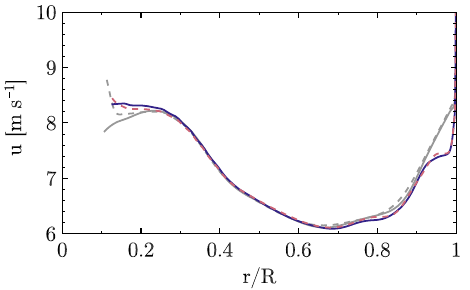
Figure 13. Radial distribution of the axial inflow velocity for CaseIsoRotor (dashed) and CaseT1.0 (solid) using the RAV method (gray) and the line average method (colored).